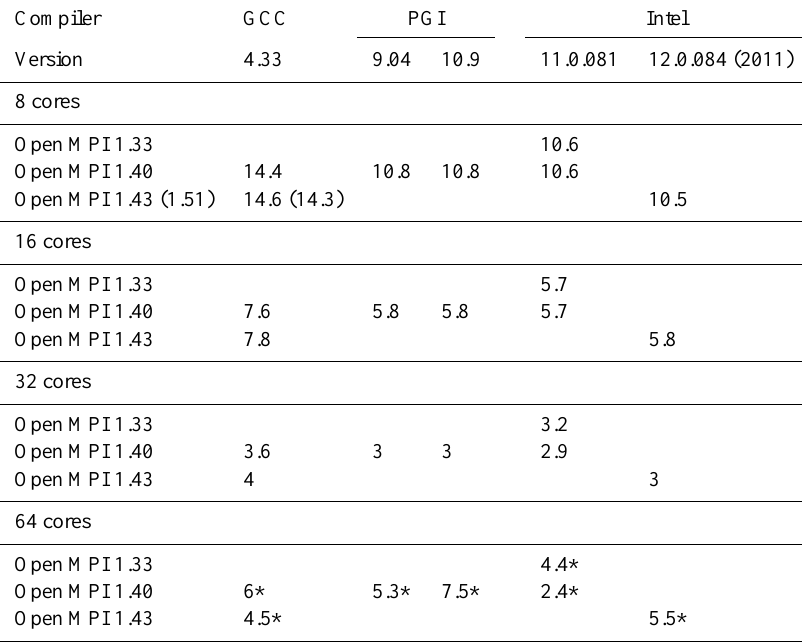
Table 1. Results for WRF 3.2.1. All results are minimal seconds needed for one of 45 model time steps of the Default January 2000 case at 3.33km horizontal resolution. The strongly varying and sometimes not reproducible ( > 5 runs) results of runs with 64 cores are marked *. (To compare the results with other benchmarks like CONUS one may calculate the “simulation speed” (Michalakes, 2010). As example for the Intel 12 compiler at 8 cores it is 20s/10.5s = 1.9, where 20 is the always identical simulation time step.) Compiler GCC